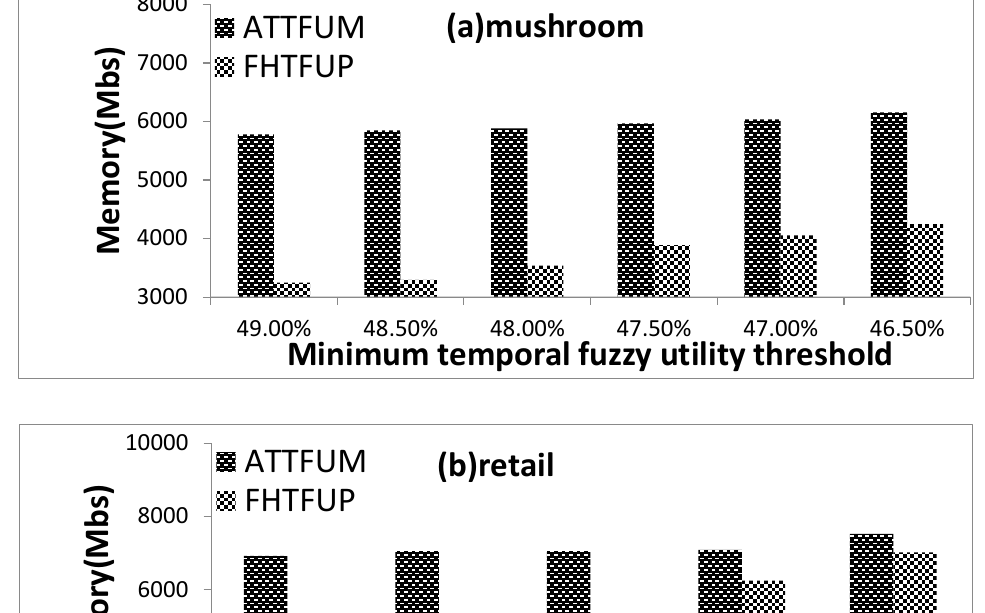
Figure 6. The comparison of running time for the two methods with different thresholds.